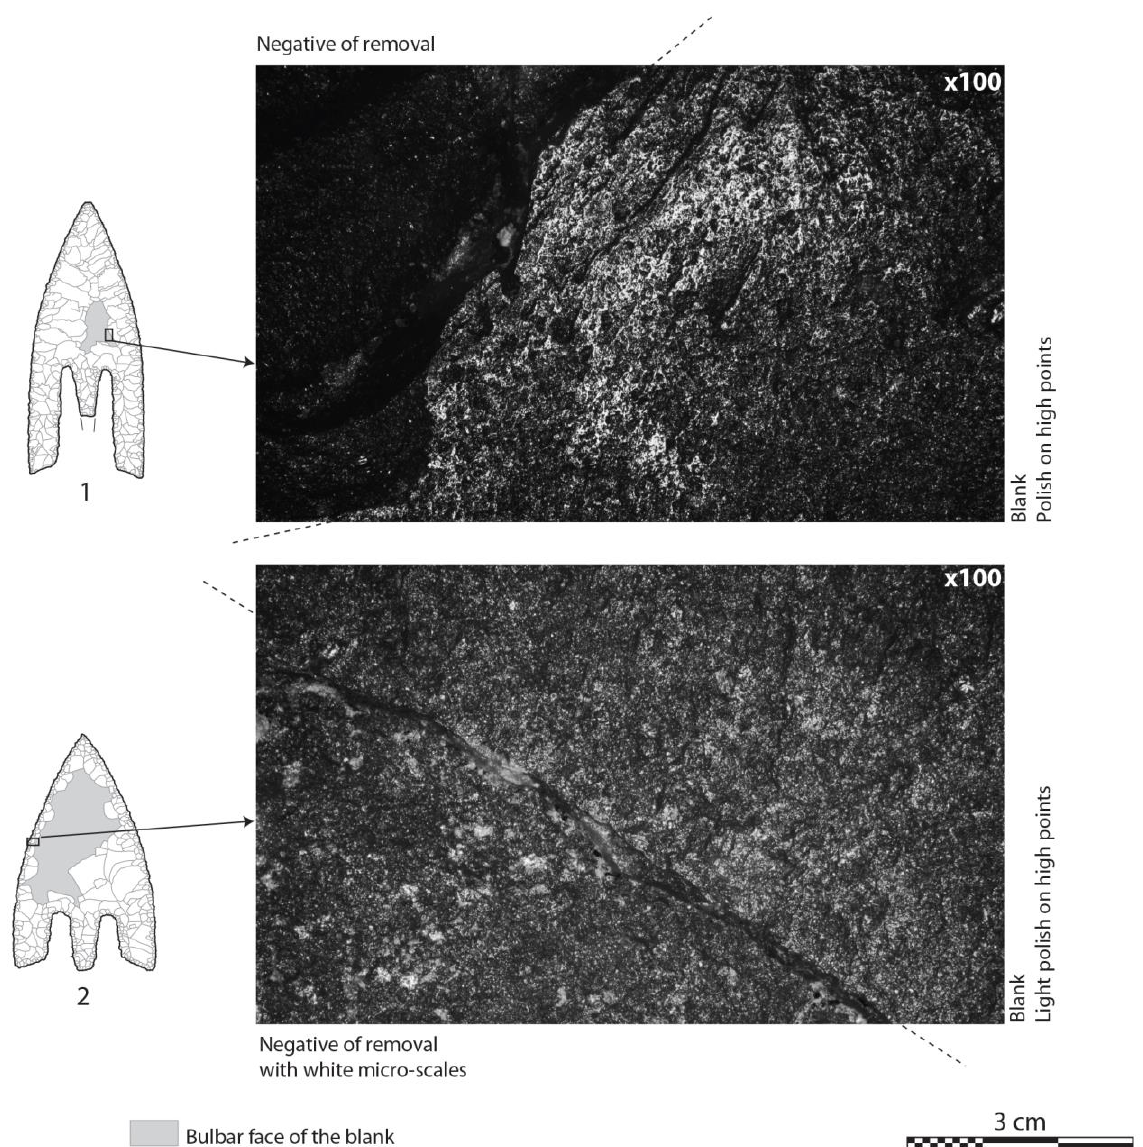
Figure 11. Use wear analysis of two Armorican arrowheads (photo C. Guéret; drawing C. Nicolas). 1. arrowhead from Prat-ar-Simon-Pella grave, Lannilis, Finistère; 2. arrowhead from Crec’h-Perros barrow, Perros-Guirec,